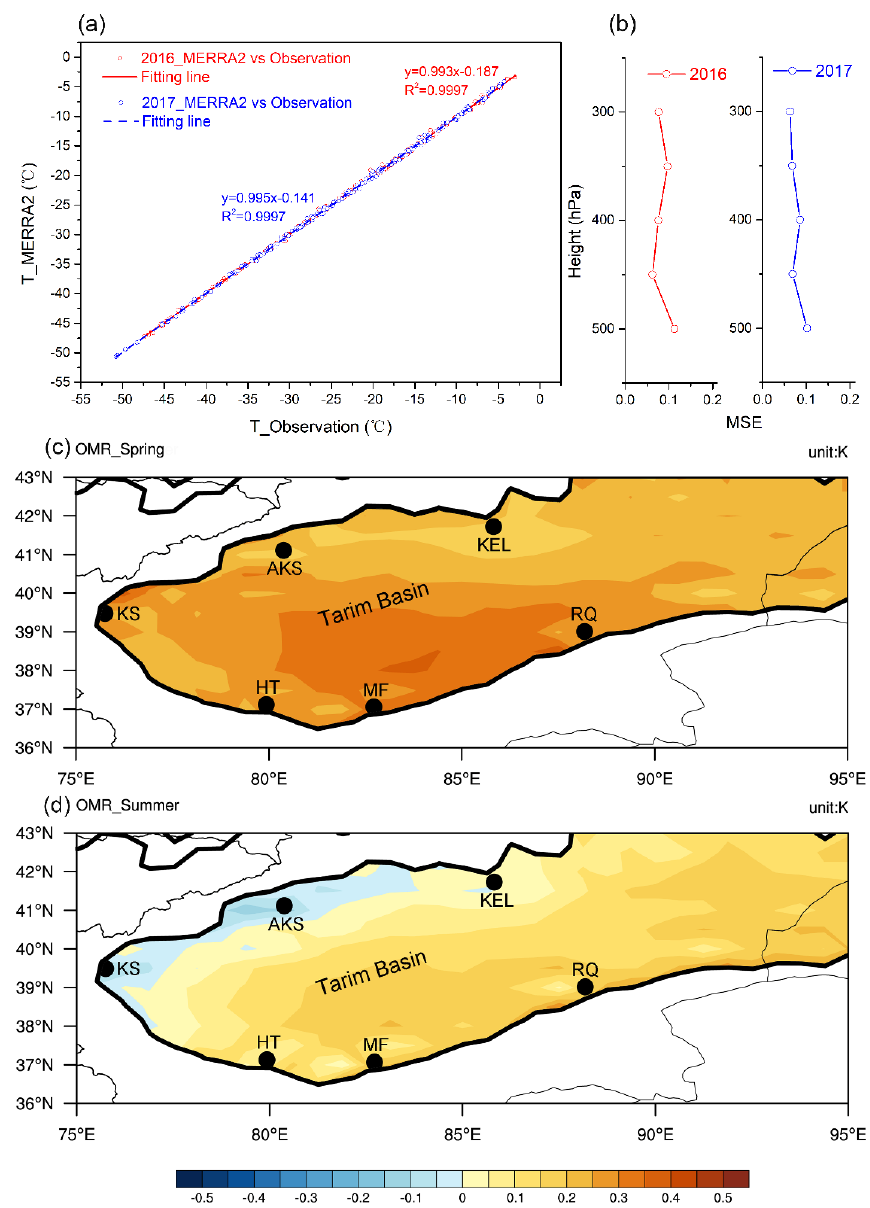
Figure 7. (a) Relationship between radiosonde temperature observations and MERRA-2 data at 500–300hPa altitude in the spring and summer of 2016–2017. (b) Mean square errors (MSEs) between the radiosonde observations and MERRA-2 data at each layer between 500 and 300hPa. Distributions of the temperature difference between MERRA-2 and ERA-5 data (OMR) averaged over 500–300hPa in the (c) spring and (d) summer of 2016–2017. Black dots indicate the site